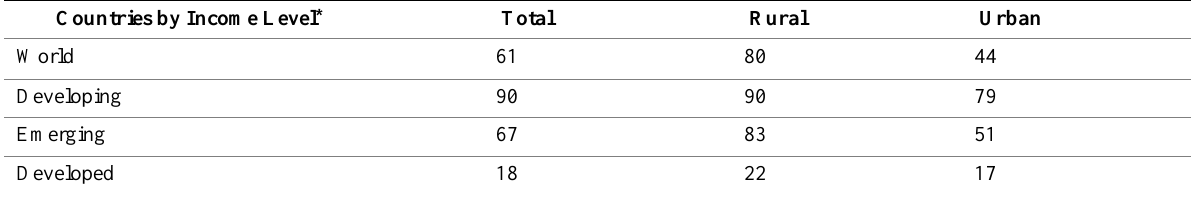
Table 1: Statistical Data on Global Informal Employment as % of Total Rural and Urban Employment Countries by Income Level * Total